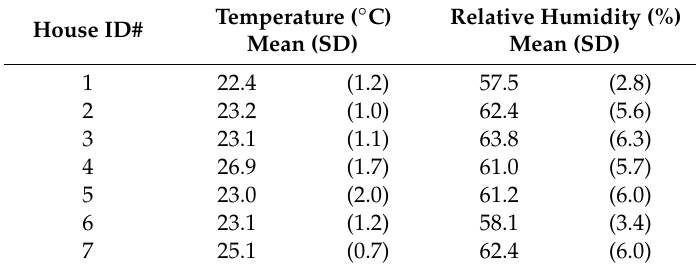
Table 5. Mean and standard deviation (SD) of the annual indoor temperature and humidity of the seven monitored